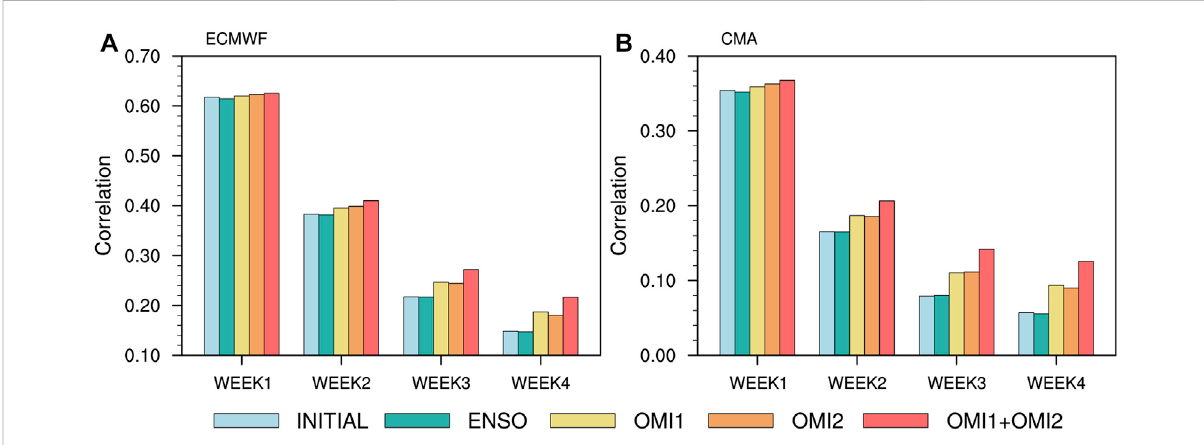
The regionally averaged correlations between hindcasts and observed precipitation anomalies over MC in the initial model output and experiments after replacing the modeled regression patterns associated with drivers of ENSO, OMI1, OMI2, and OMI1+OMI2 with the observed regression patterns for ECMWF (A) and CMA (B) , respectively.